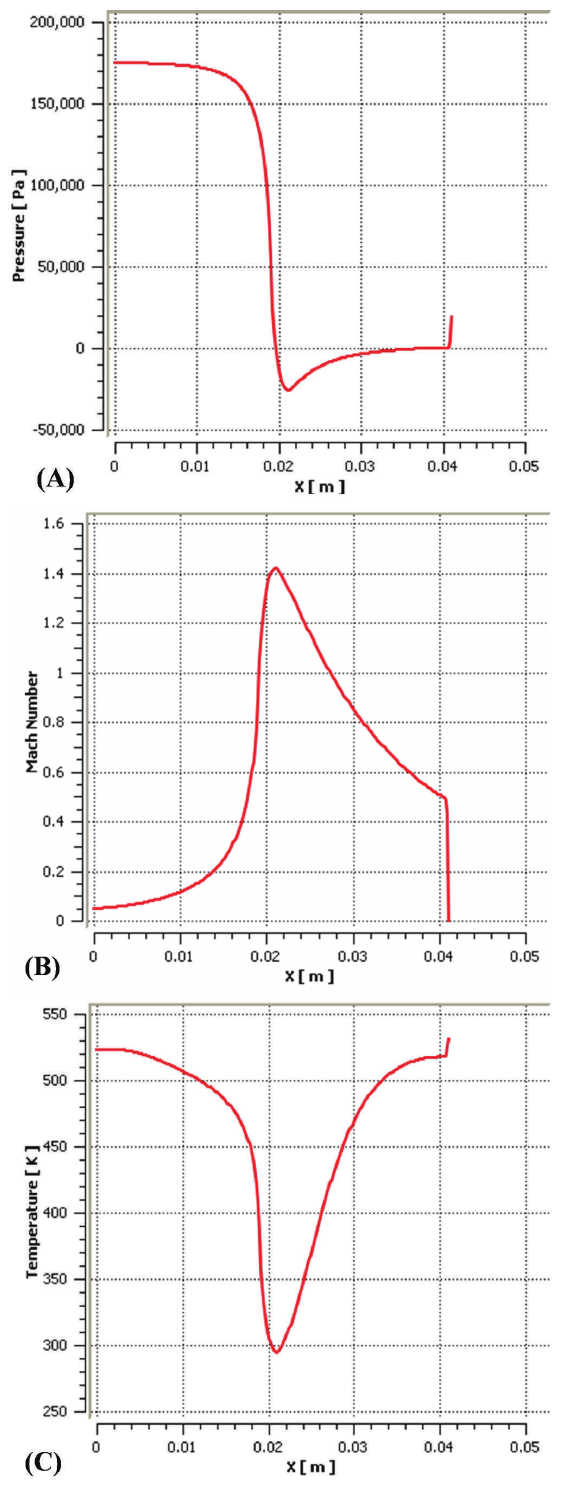
Figure 3. Pressure (A), Mach number (B) and temperature (C) of gas along the centerline in the converging-diverging nozzle and plenum [24].